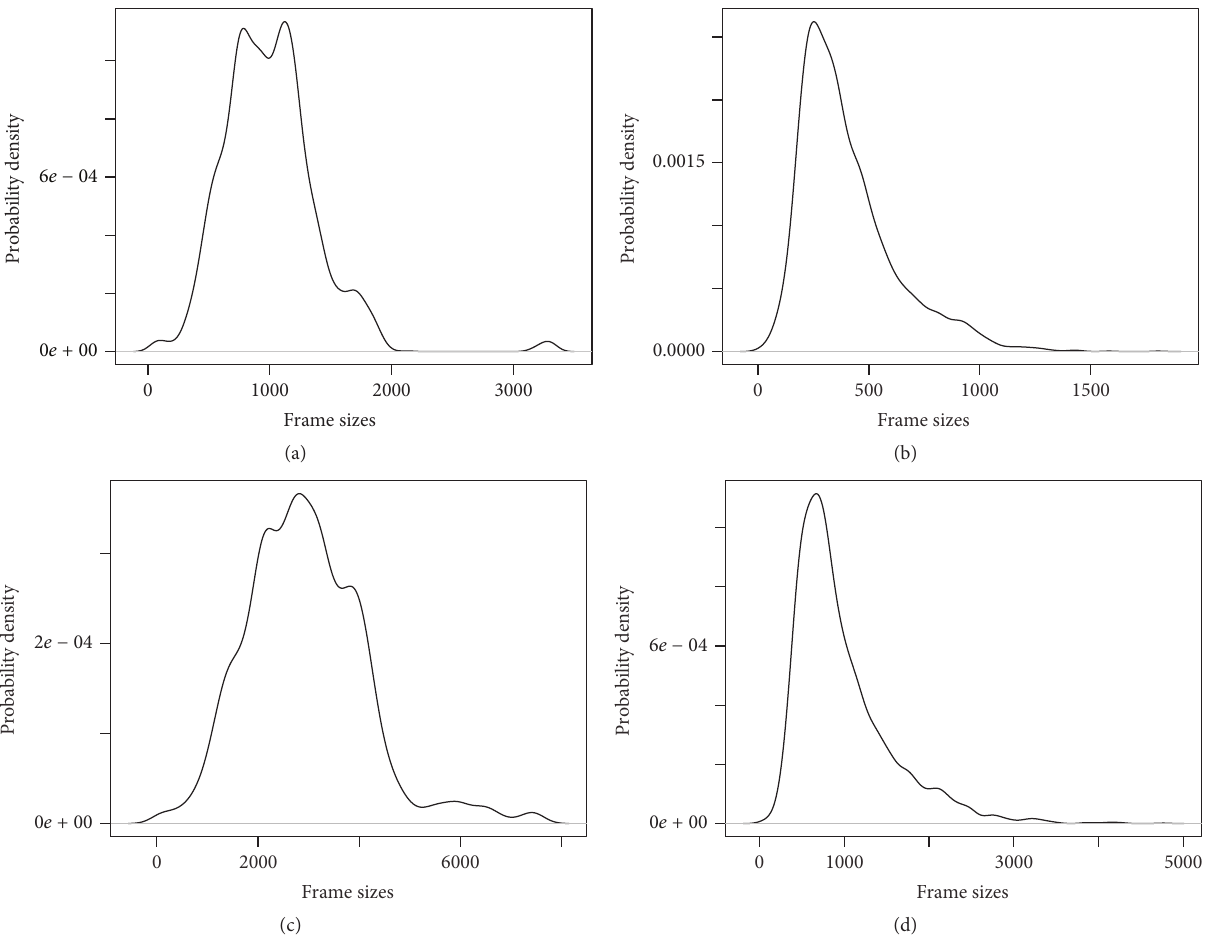
Figure 1: (a) The probability density function of I frame, in base layer of NBC News. (b) The probability density functions of B frame, in base layer of NBC News. (c) The probability density function of I frame, in enhancement layer of NBC News. (d) The probability density function of I frame, in enhancement layer of NBC